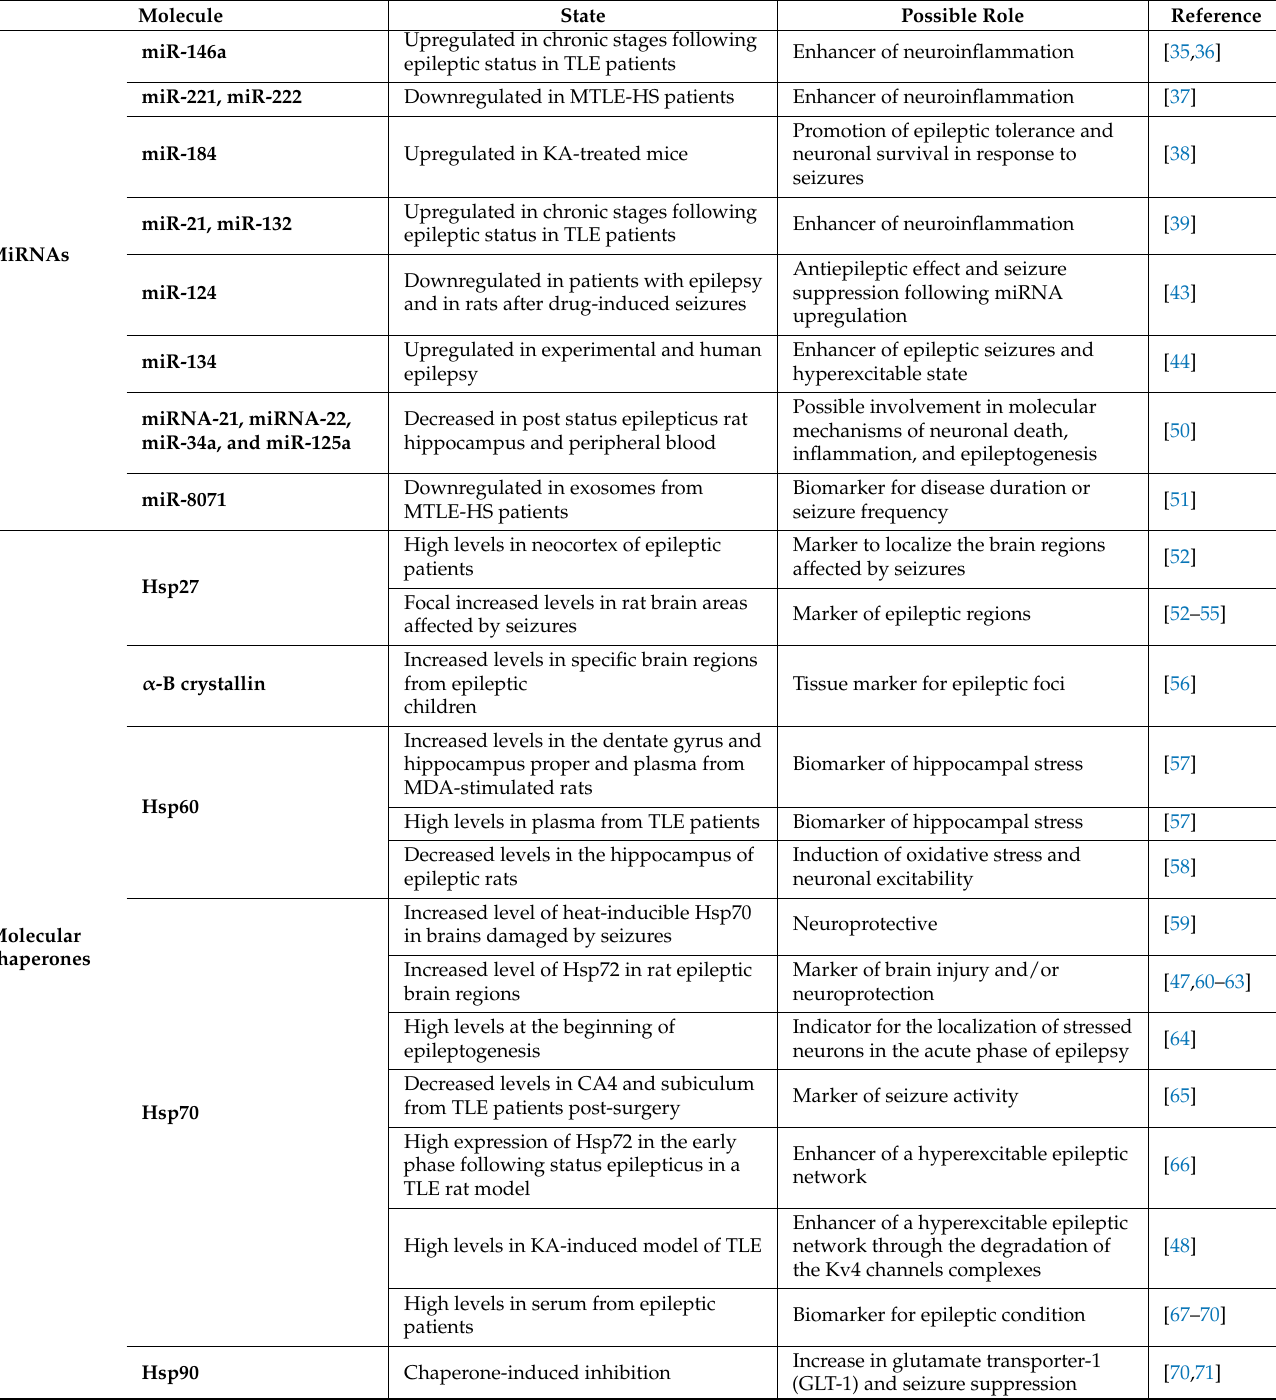
Table 1. Representative examples of molecular chaperones and miRNAs involved in